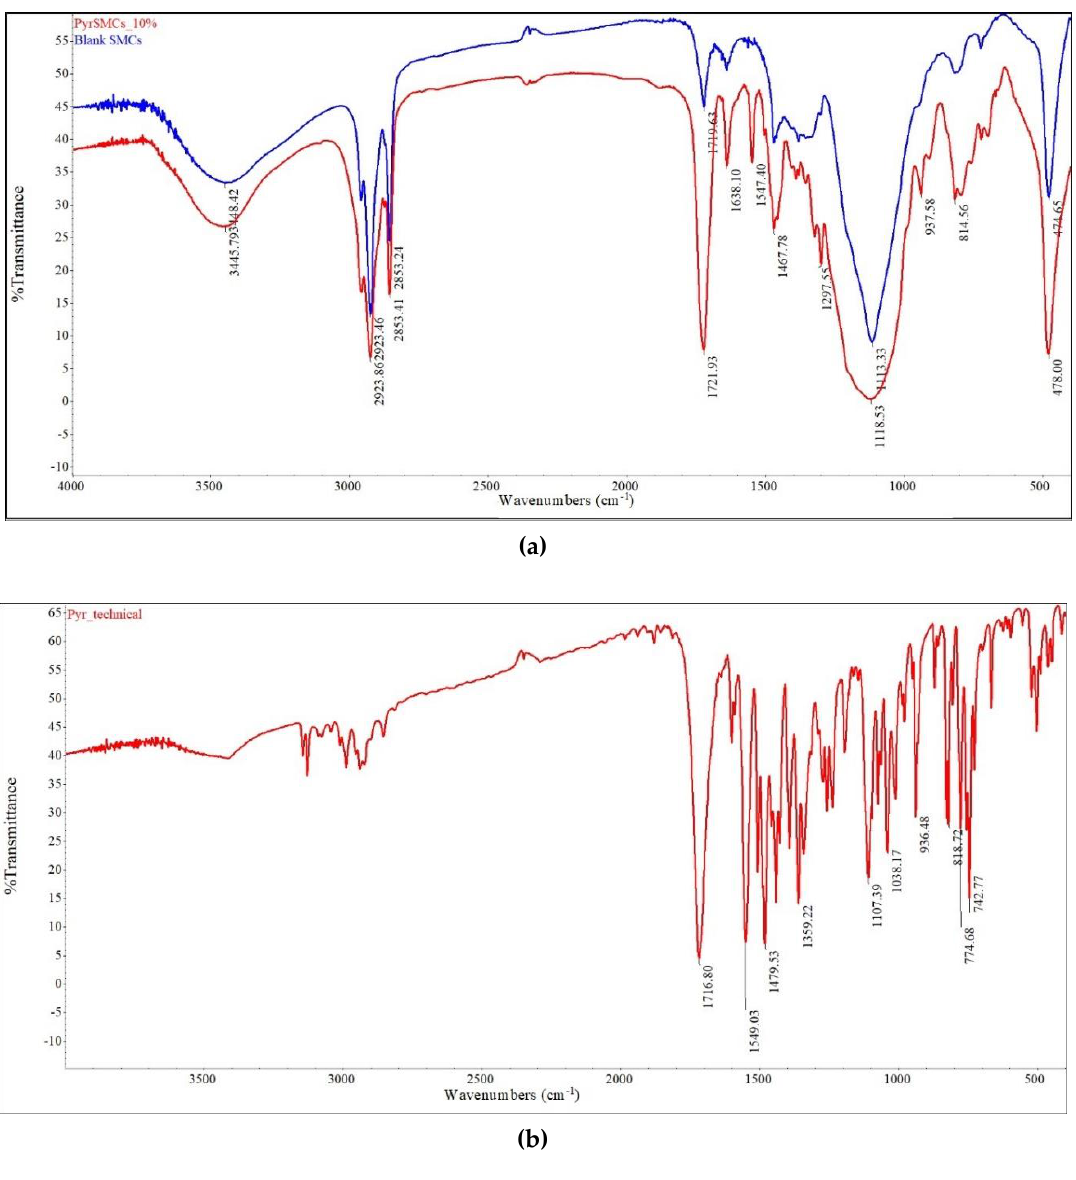
Figure 7. Infrared spectrogram: ( a )—SMCs (red – blank SMCs, blue – PyrSMCs), ( b )—pyraclostrobin of technical grade .